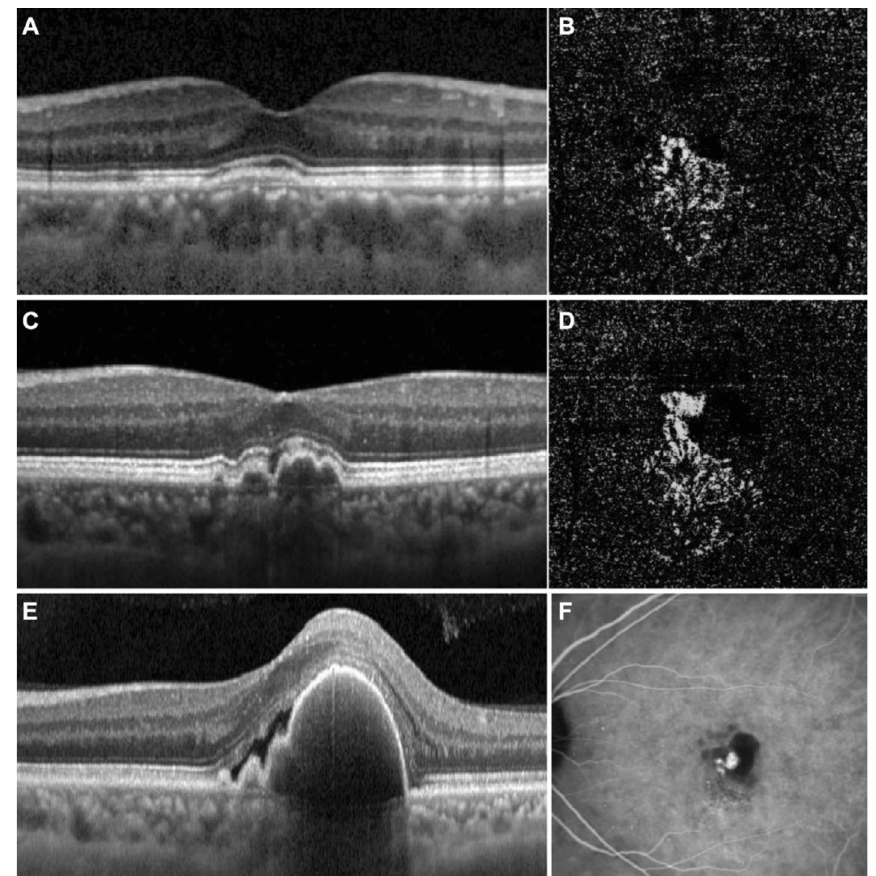
Figure 4. Images showing a temporal change in the images of the left eye of a 69-year-old male, in which non- exudative PNV transformed to PCV. ( A and B ), OCT and OCTA images of non-exudative PNV at baseline. There is no protruding RPED corresponding to a polyp, and there is no exudative change, such as subretinal fluid or intraretinal cyst formation, other than DLS. ( C and D ), Images taken 8 months after baseline. Note the increased height of the RPED on structural OCT and the enlargement of the extent of MNV on OCTA. ( E and F ), OCT and ICGA images after transformation to PCV 14 months after baseline. ICGA image demonstrates polyps and branching vascular networks. PNV, pachychoroid neovasculopathy; PCV, polypoidal choroidal vasculopathy; OCT, optical coherence tomography; OCTA, optical coherence tomography angiography; DLS, double layer sign; RPED, retinal pigment epithelial detachment ; MNV, macular neovascularization ;ICGA, indocyanine green angiography.